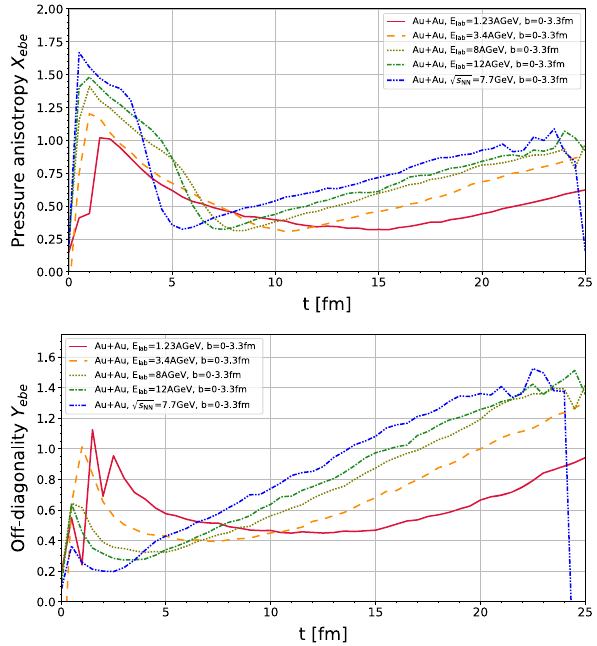
Fig. 3 Time evolution of the pressure anisotropy X ebe (upper plot) and off-diagonality Y ebe (lower plot) in the center of the system. The plots refer to Au+Au collisions, 0–5% centrality class, at E lab = 1.23, 3.4, 8, √ s NN = 7.7 GeV 12 AGeV and